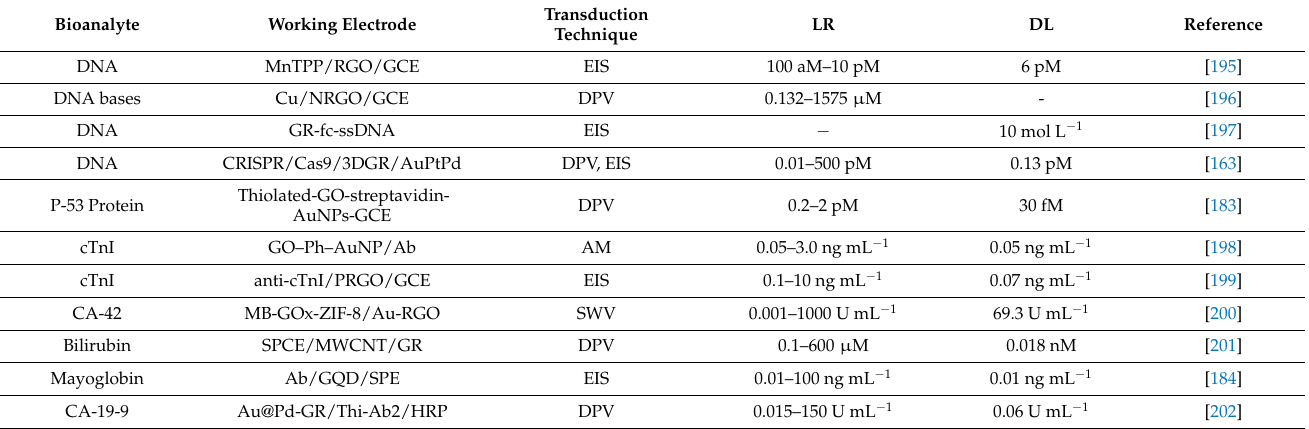
Table 2. List of various DNA sensors and immunosensors based on GR-NCs reported in the